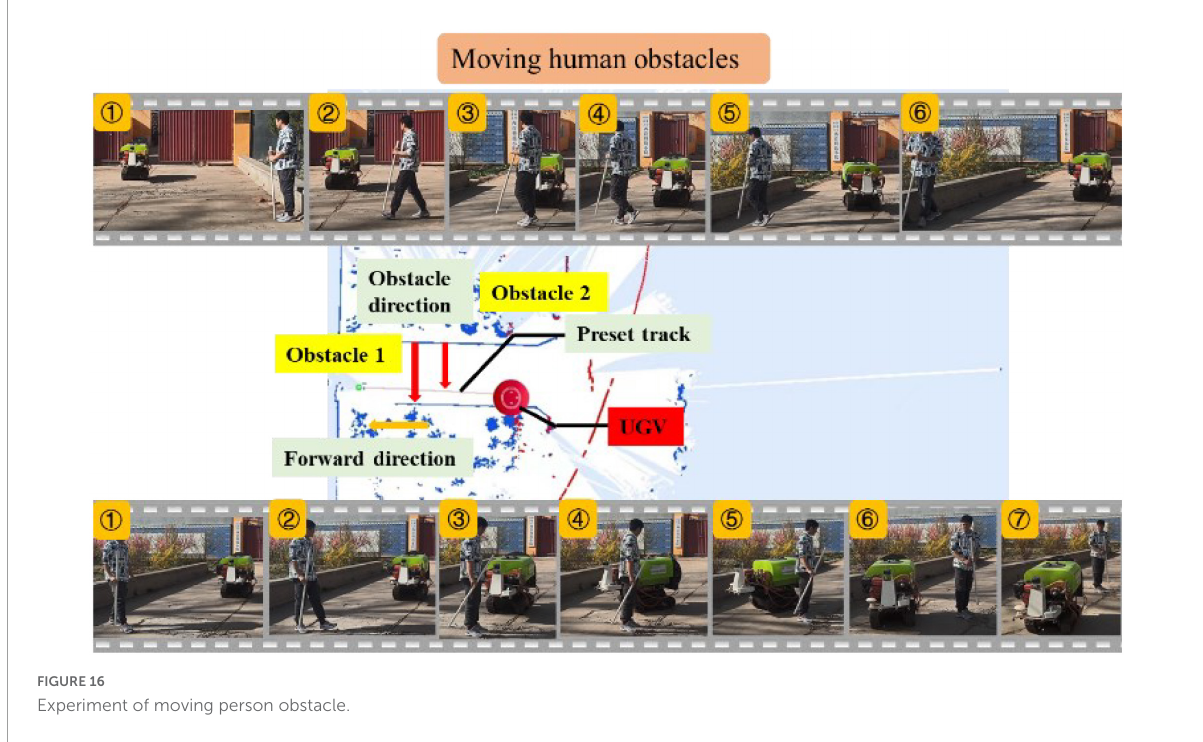
FIGURE16 Experiment of moving person obstacle.